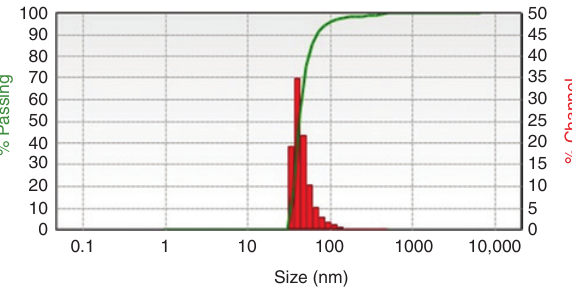
Figure 5: Dynamic light scattering of the synthesized AgNPs at obtained optimum synthesis conditions.